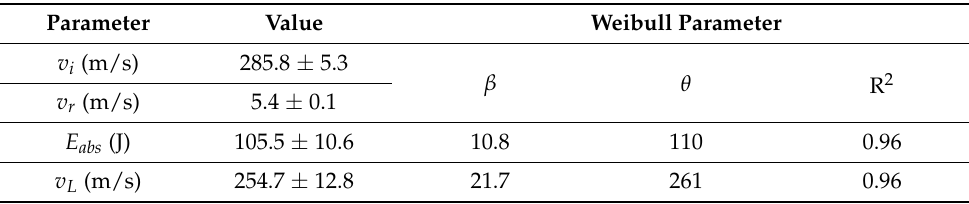
Table 4. Standalone ballistic test results and Weibull parameter for the epoxy composite reinforced with 30 vol% of guaruman fibers in cross-laid configuration.